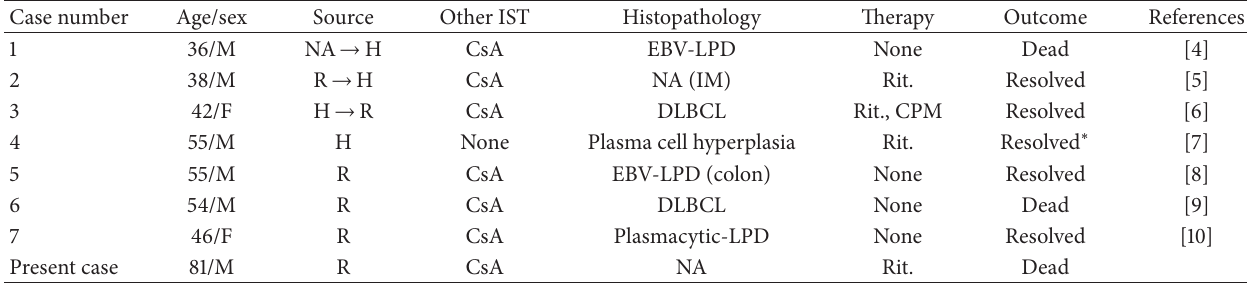
Table 1: Reported cases of EBV-LPD after ATG therapy for aplastic